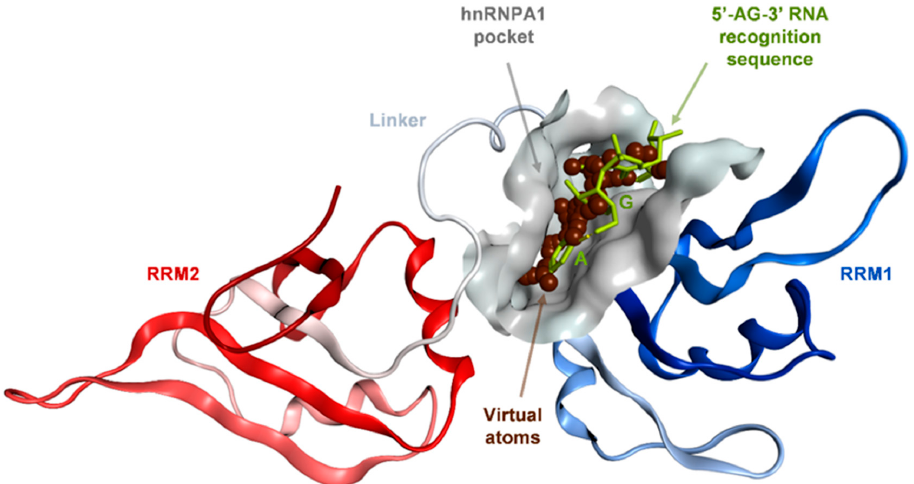
Figure 1. In silico model of the UP1 domain of the hnRNP A1 splicing factor bound to the 5 ′ -AG-3 ′ recognition sequence constructed based on the 1.92 Å X-ray structure of RNA-bound UP1 (PDB ID: 4YOE). The RNA bases are shown as sticks and colored in green. The predicted binding site on hnRNP A1 at the RNA recognition interface is represented as a grey solid surface. Virtual atoms utilized to probe the protein surface are shown as brown spheres within the identified pocket. RRM: RNA recognition